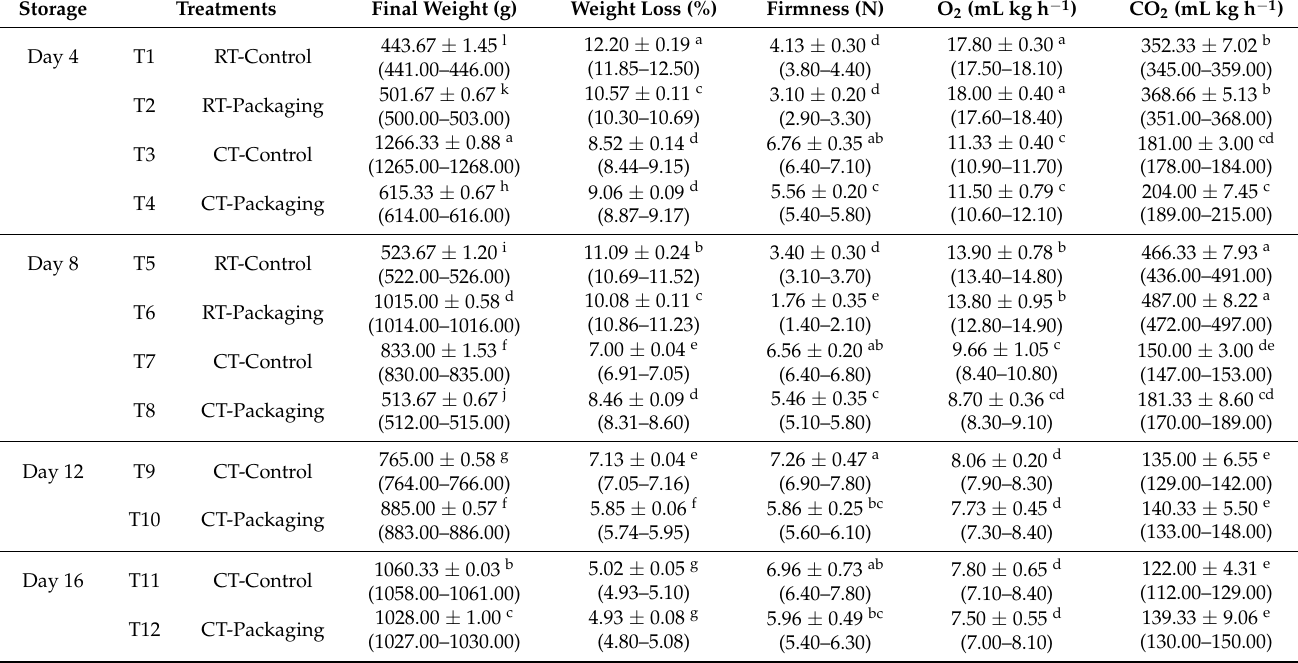
Table 2. Physical characterization of Artocarpus odoratissimus fruits at different postharvest